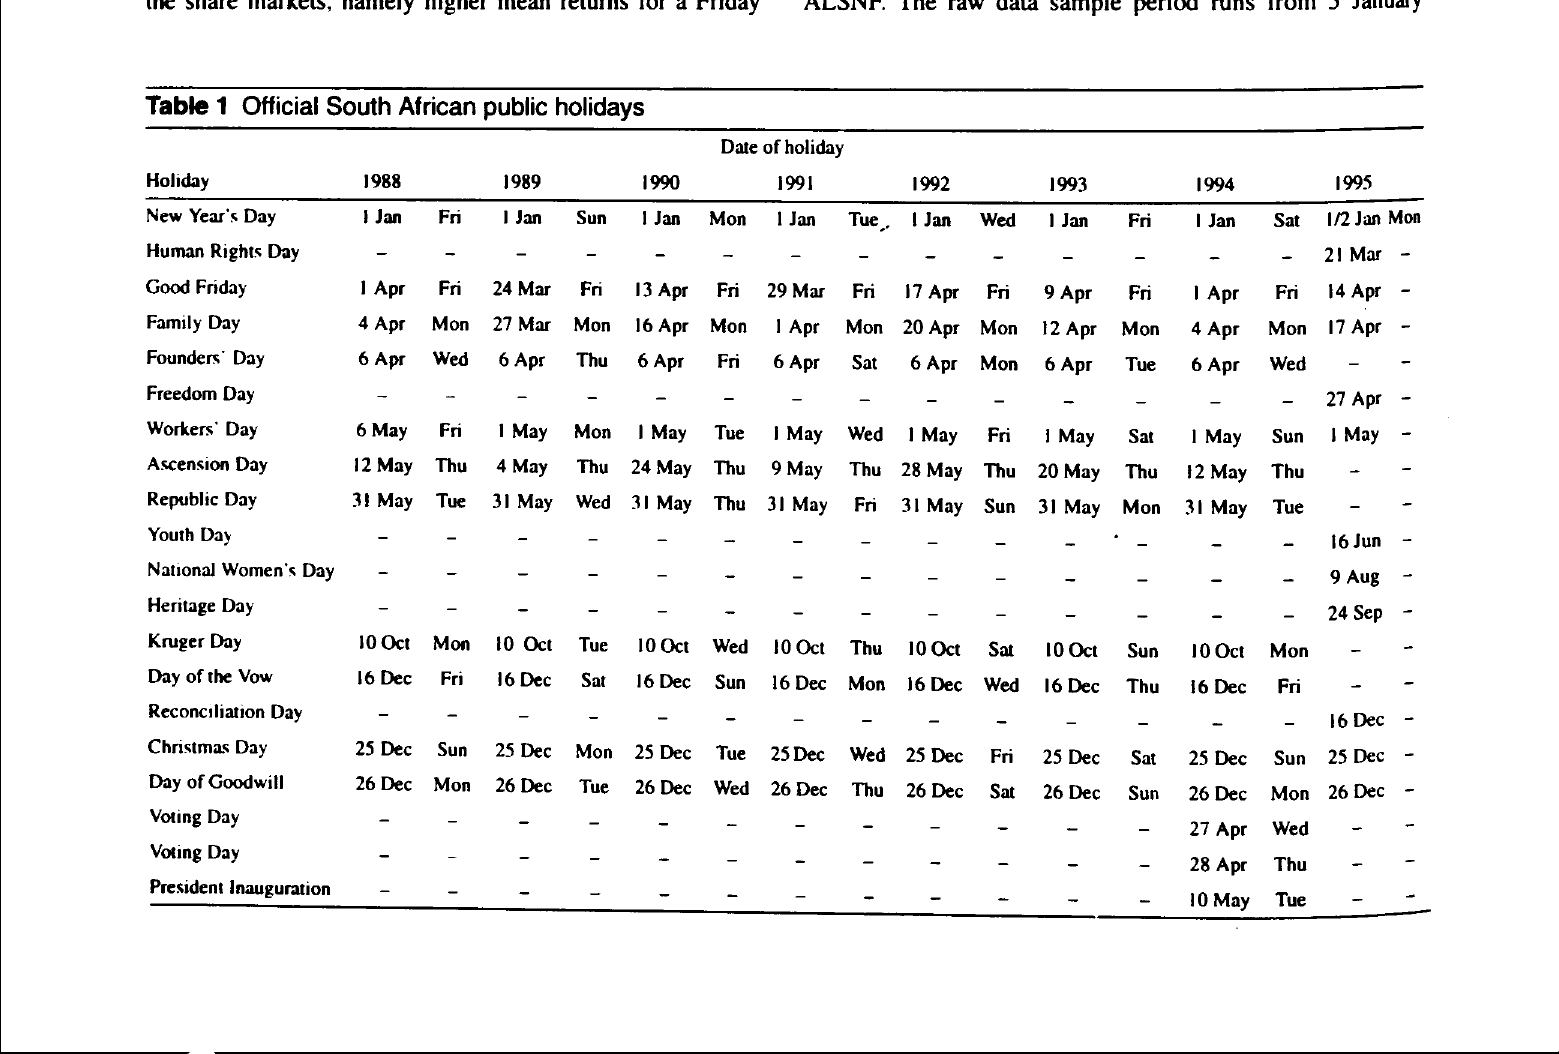
Table 1 Official South African public